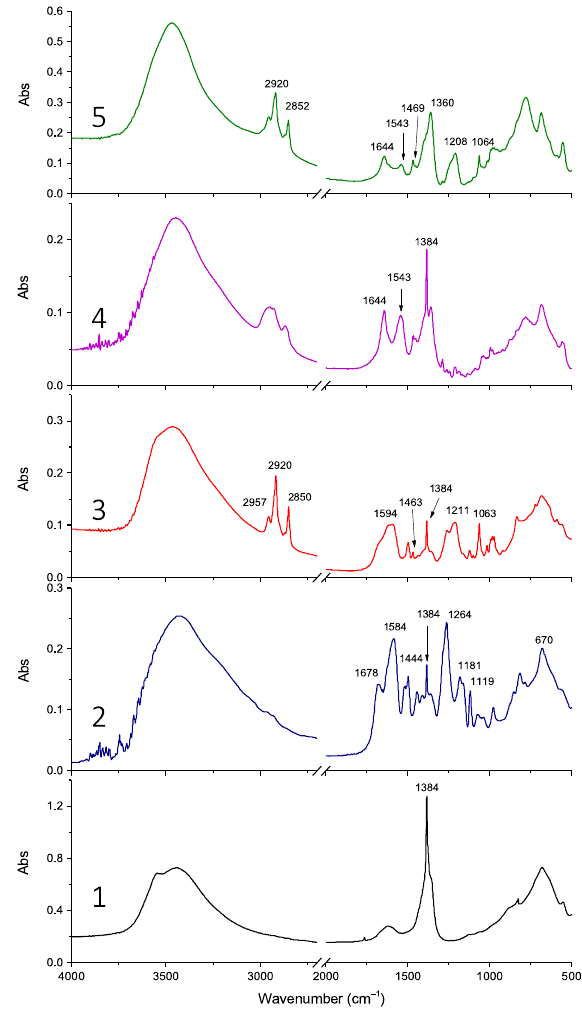
Figure 3. FT-IR spectra of samples LDH-NO 3 (1), LDH-RA (2), LDH-DS/RA (3), LDH-GA (4), and LDH-DS/GA (5).